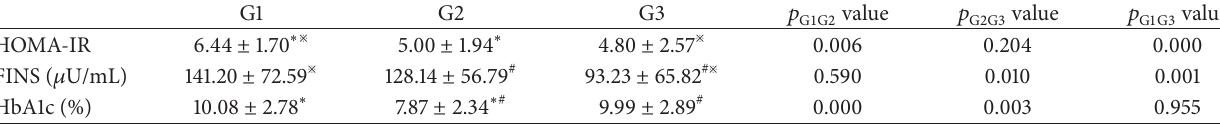
Table 2: Comparison of G1, G2, and G3 of HOMA-IR and glucose metabolism indices (FINS, HbA1c). G1 G2